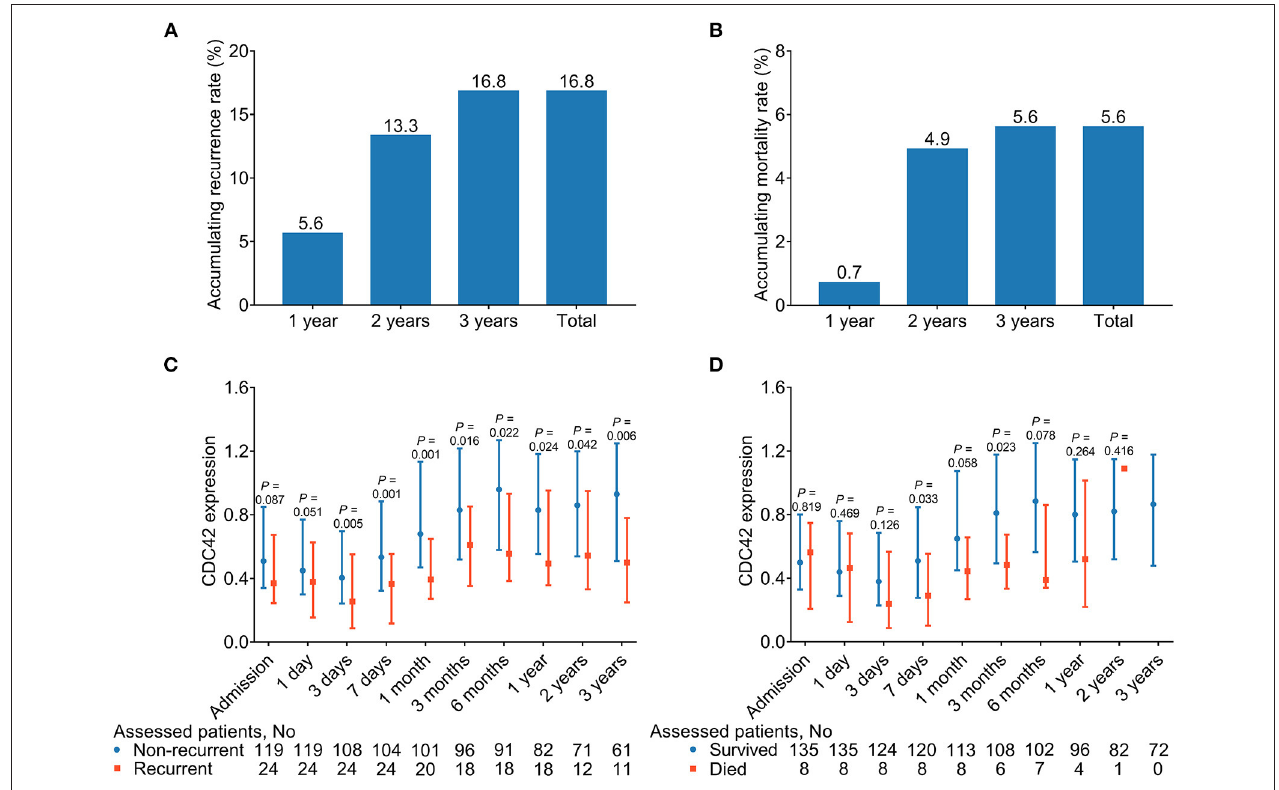
FIGURE 6 | CDC42 was decreased in recurrent patients (vs. non-recurrent patients) and deceased patients (vs. survived patients) at some time points. Accumulating 1-, 2-, and 3-year, total recurrent (A) and mortality (B) rates in patients with AIS. Comparison of CDC42 at different time points in recurrent patients (vs. non-recurrent patients) (C) and deceased patients (vs. survived patients) (D)